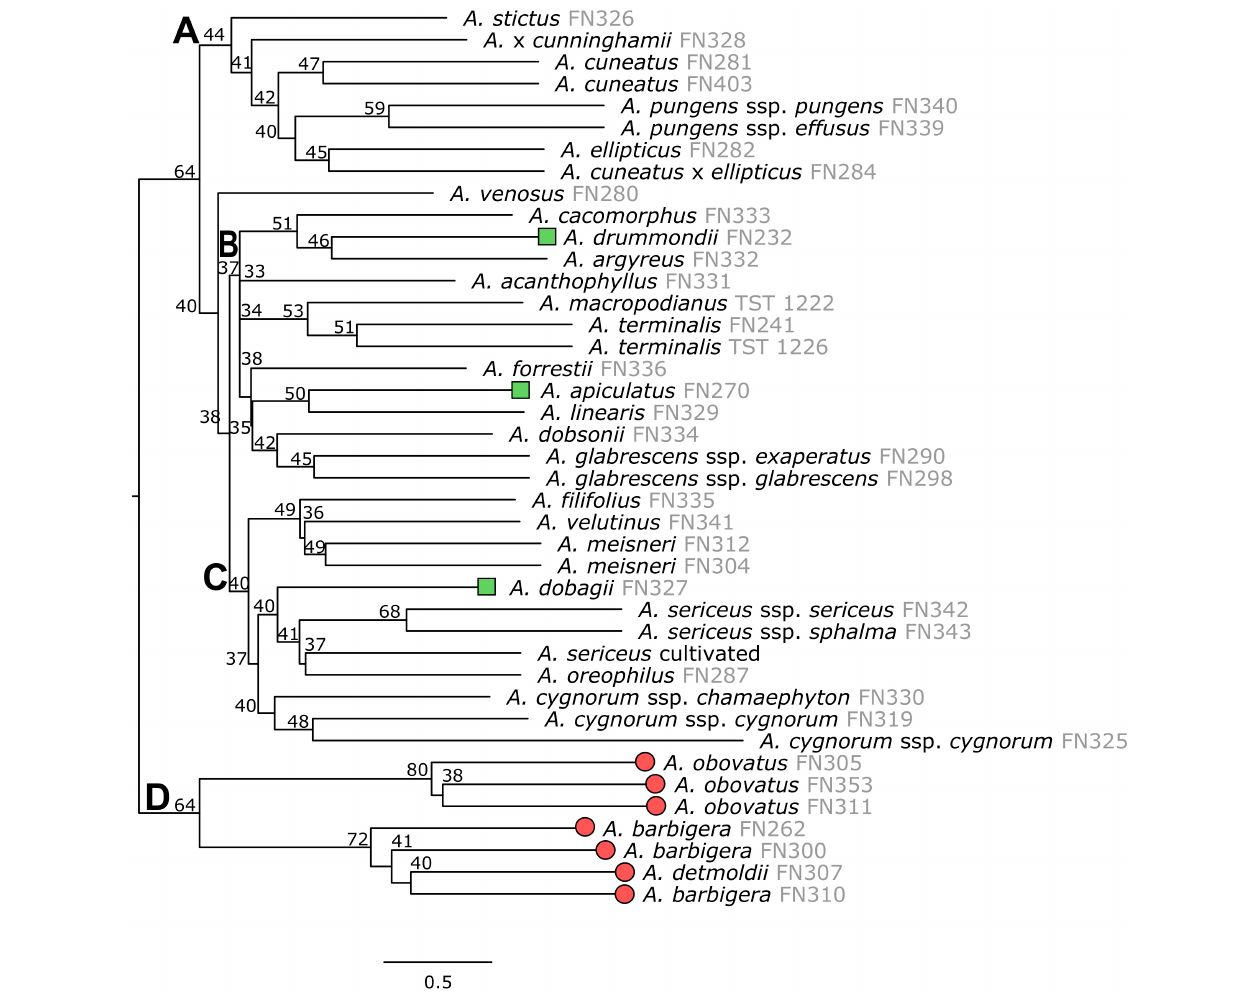
FIGURE 3 | ASTRAL species trees of Adenanthos inferred using the multispecies coalescent model and gene trees of nuclear loci. Support values for the ASTRAL tree represent the local quartet score of each branch. Letters (A–D) refer to clades discussed in text. Terminal tips represent taxa from A. sect. Eurylaema (red circles), A. sect. Adenanthos subsect. Anaclastos (green squares), and A. subsect. Adenanthos